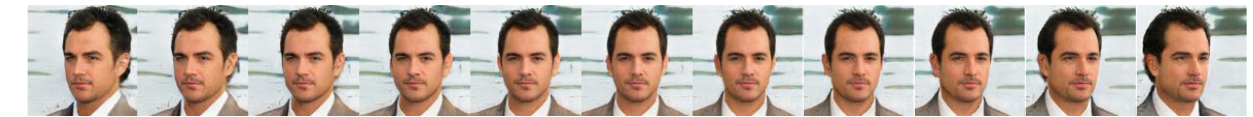
Figure 2. Synthesized texture dataset generation method.